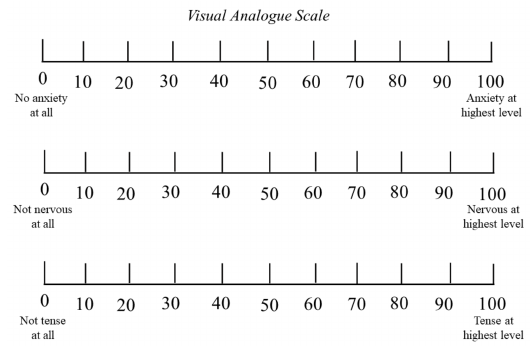
Figure A1. The visual analogue scale for anxiety